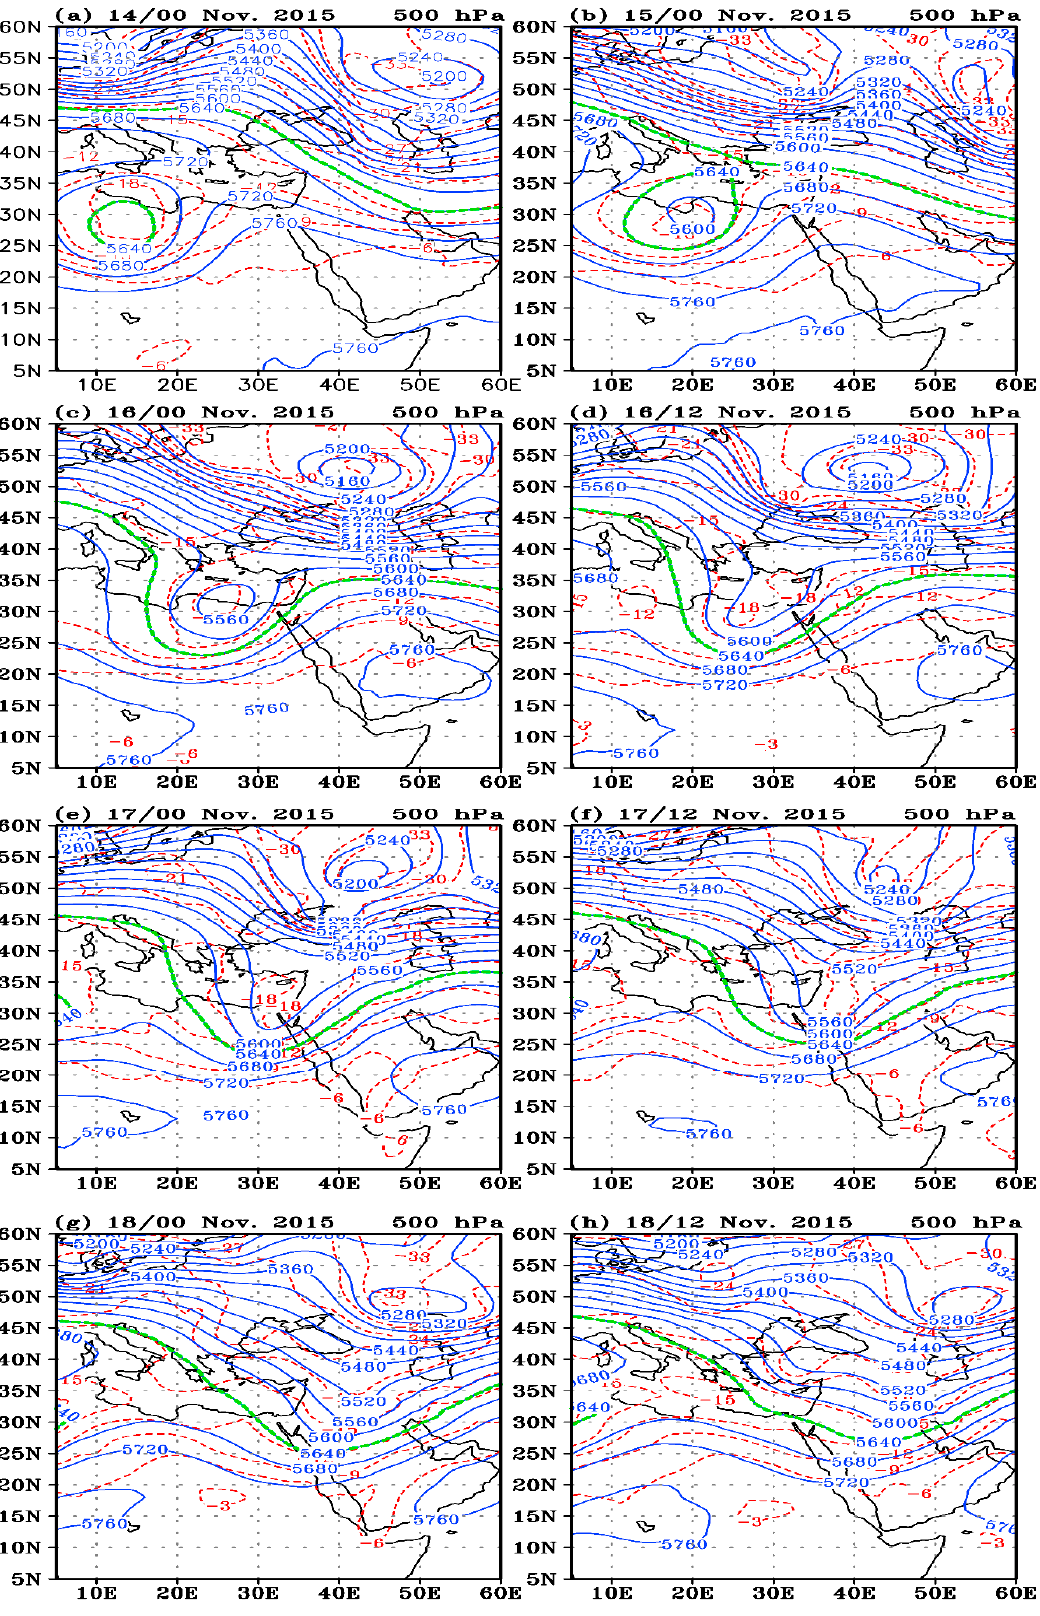
Figure 3. 500 hPa geopotential height with 40 m contour intervals (blue and green solid lines) and temperature (red dashed lines) every 3 °C ( a – h ) for the period 14–18 November 2015.